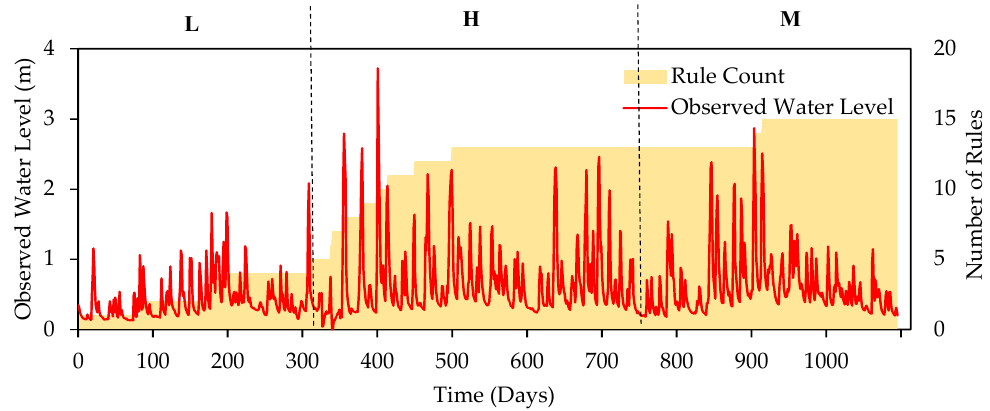
Figure 10. Comparison of observed water level time-series with DENFIS rule number progression for training combination LHM in Dandenong catchment.